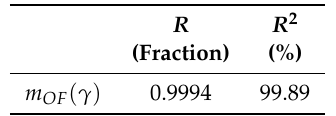
Figure 3. Behavior of m OF with respect to variations in γ . %TO: percentage of transmitter output, %CO: percentage of controller output, UT: units of time. Table 2. Statistics for m OF ( γ ) (nonlinear regression of Figure